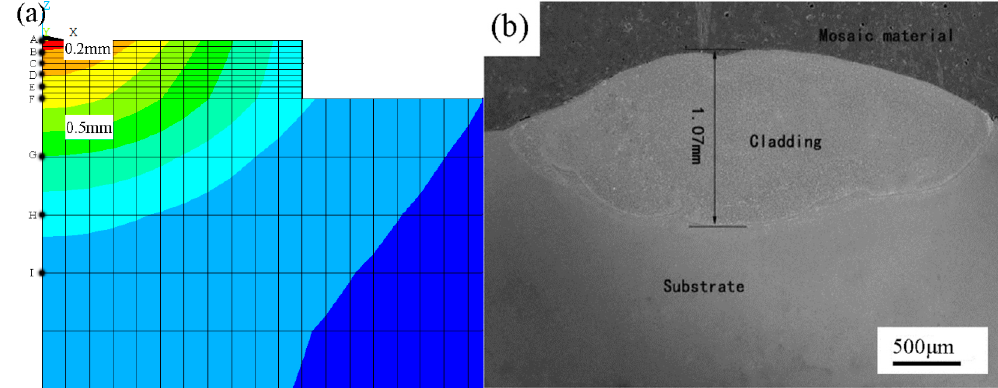
Figure 13. A comparison of the cross-sections between ( a ) the simulation result and the location of the monitoring points and ( b ) the experimental result. Reprinted with permission from [14]; Copyright 2018 Elsevier.